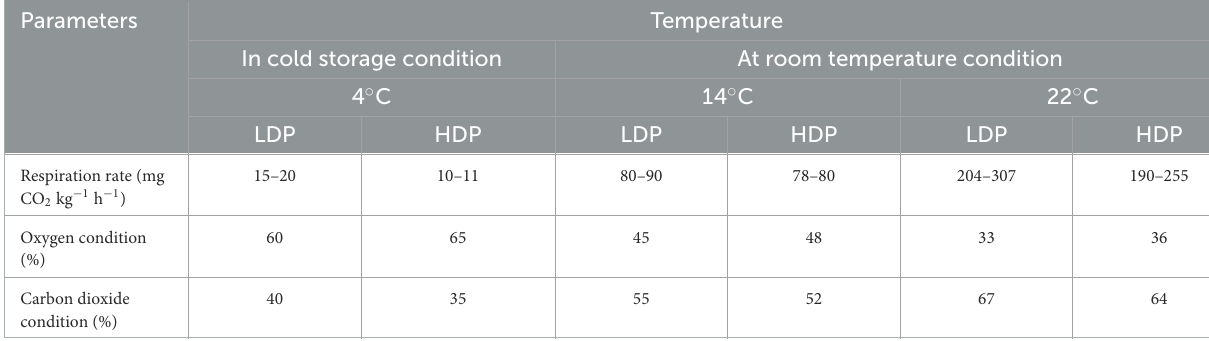
TABLE 4 CO 2 and O 2 conditions and respiration rate inside the